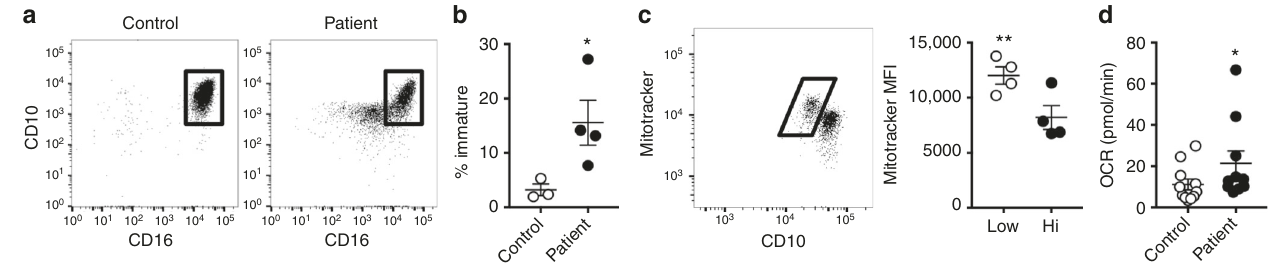
Fig. 7 Cancer patient neutrophils possess increased OXPHOS. a Representative fl ow cytometry plots of peripheral blood neutrophils displaying CD10 and CD16 expression from healthy controls and ovarian cancer patients. The box indicates mature neutrophils. b Quanti fi cation of immature neutrophils from multiple patients scored as a percentage of CD14 − CD15 + cells which do not express the CD10 hi CD16 hi marker pro fi le associated with maturity. Data